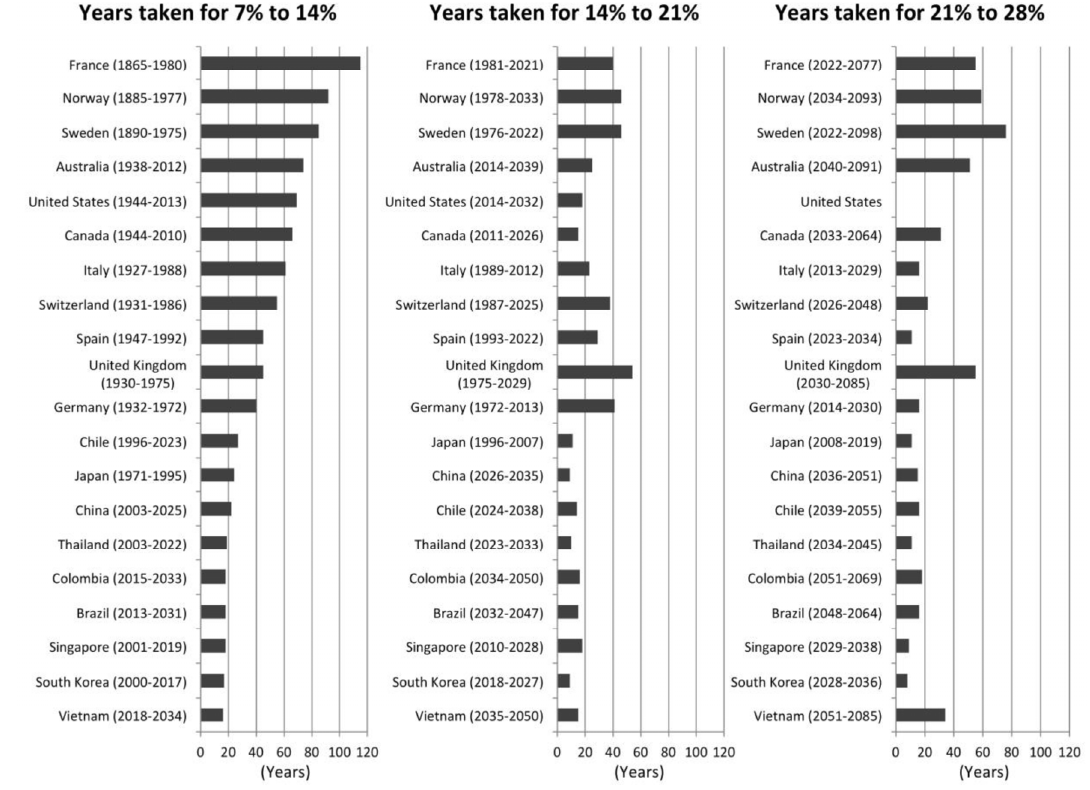
Figure 5. Number of years taken or predicted to take for three aging transitions in selected countries. Note: Created from the Organisation for Economic Co-Operation and Development (OECD) and UN demographic database. Years in parentheses are the periods during which each aging transition occurred or is predicted to